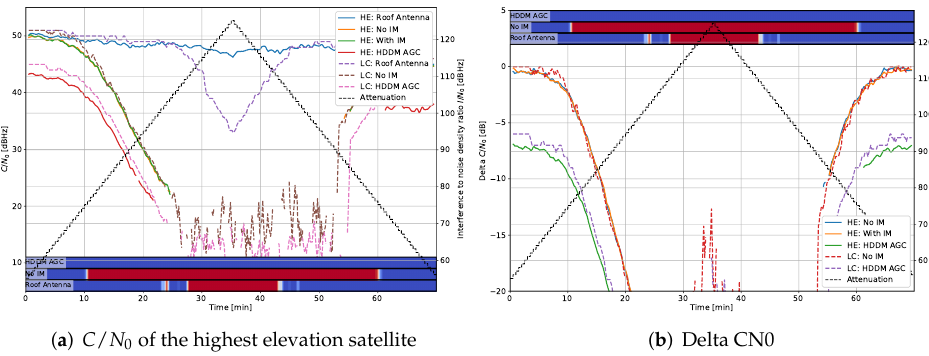
Figure A7. Interference #7: Filtered noise with 35MHz bandwidth with GPS L1/CA.